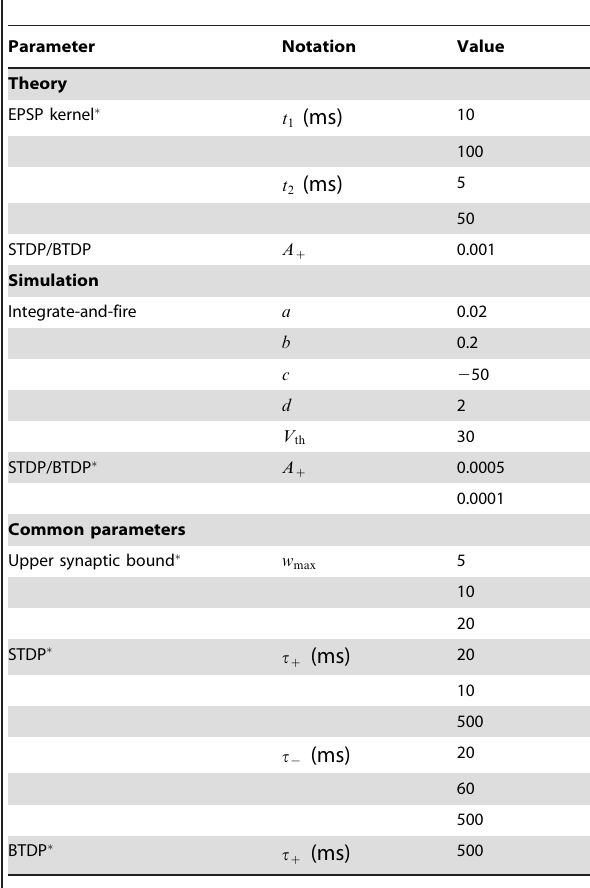
Table 3. Model parameters for generation of LGN activity using the linear model (theory) and the integrate-and-fire model (simulation), and for synaptic modification induced by STDP or